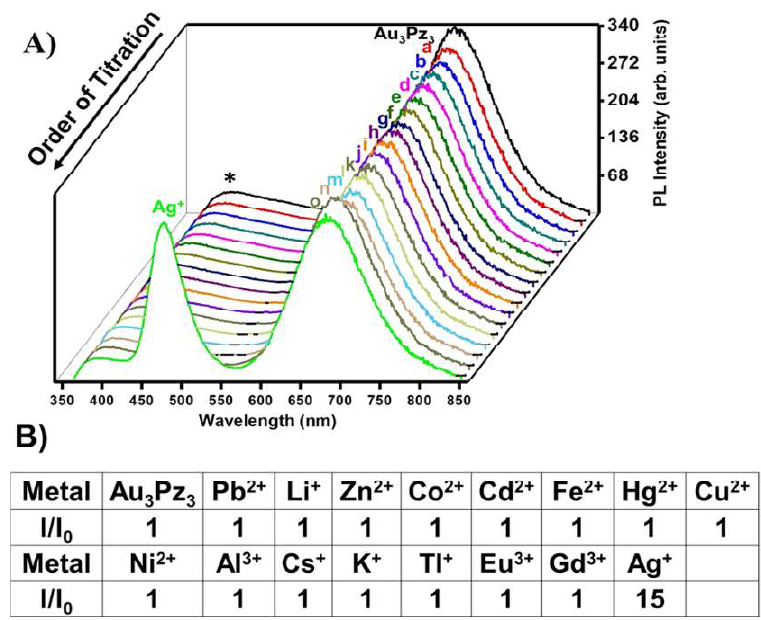
Figure 7. Demonstrates stabilizing feature of CS polymer. Formation of phosphorescent Au(I)-based molecular system and its heavy metal sensing application. In figure I , the difference in photoluminescence spectra of Au(I) molecular system stabilized in aqueous and chitosan media is shown. In figure II , the silver sensing ability of Au(I) molecular system stabilized in CS polymer is demonstrated from fluorescent images. ( A ) Changes in photoluminescence spectra of Au(I) based molecular system in the presence of various metals is shown; ( B ) Shows I/I 0 values of various metals, derived from photoluminescence spectra. The “*” indicates weak emission from impurities in chitosan. Reprinted with permission from Anal. Chem . 2018 , 90 , 4999–5006, Copyright 2018, American Chemical Society [69].